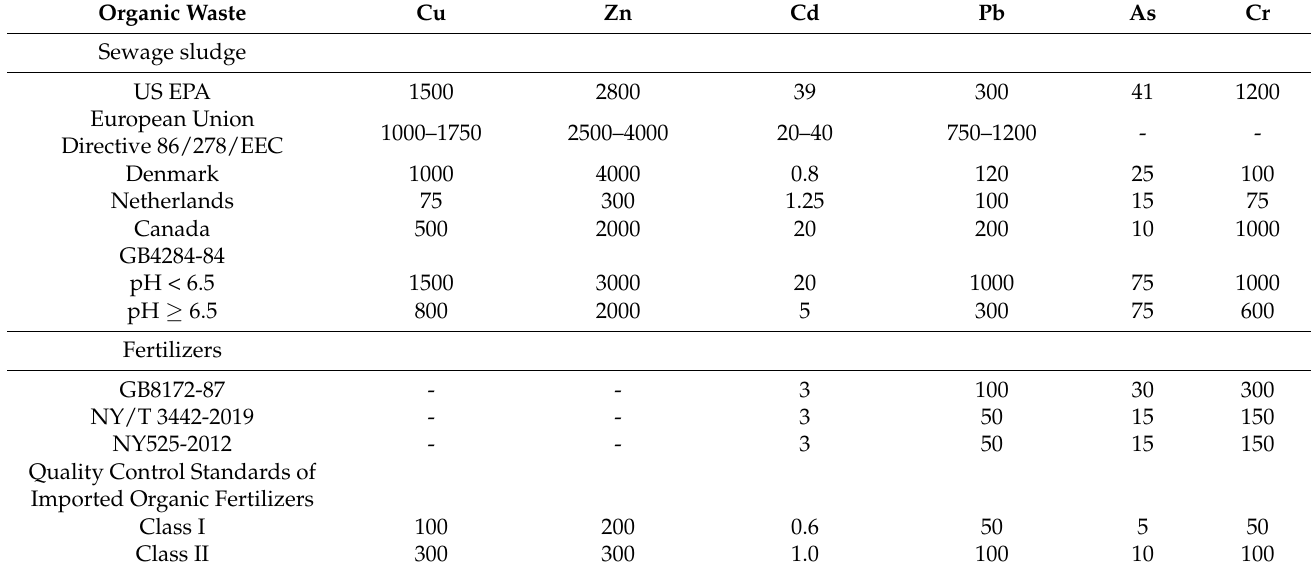
Table 3. Heavy metal limits in sewage sludge and livestock manure for different criteria (mg · kg − 1 ). Organic Waste Cu Zn Cd Pb As